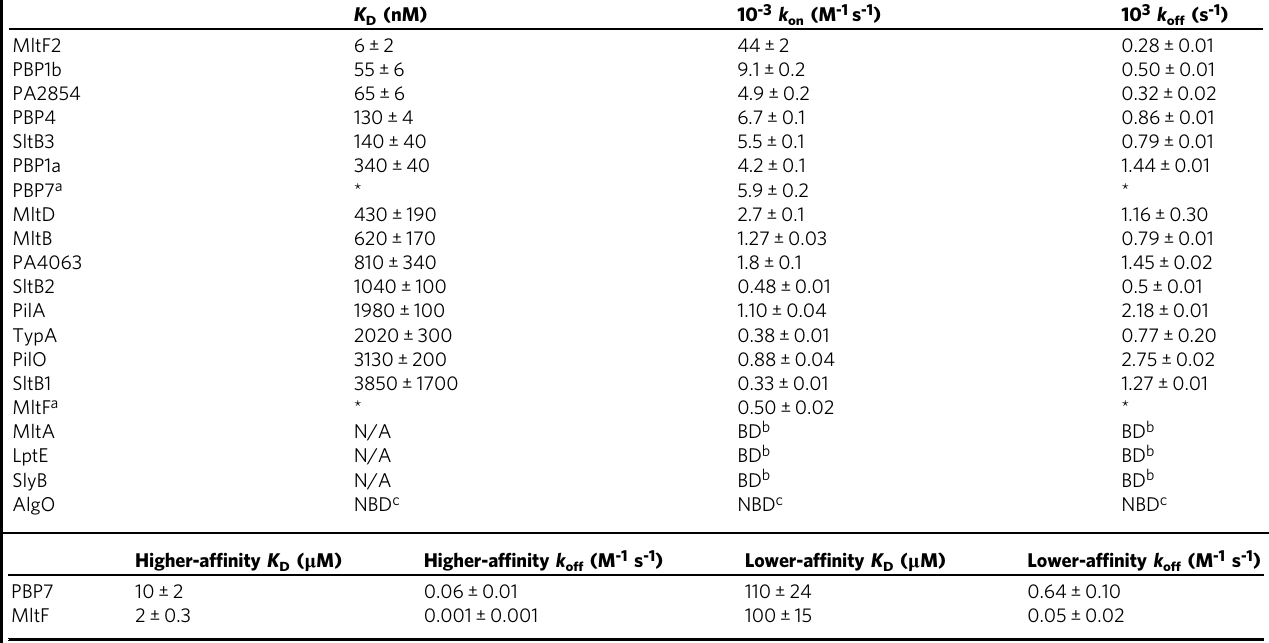
Table 2 The kinetics for RlpA- Δ 32 binary interactions as measured by